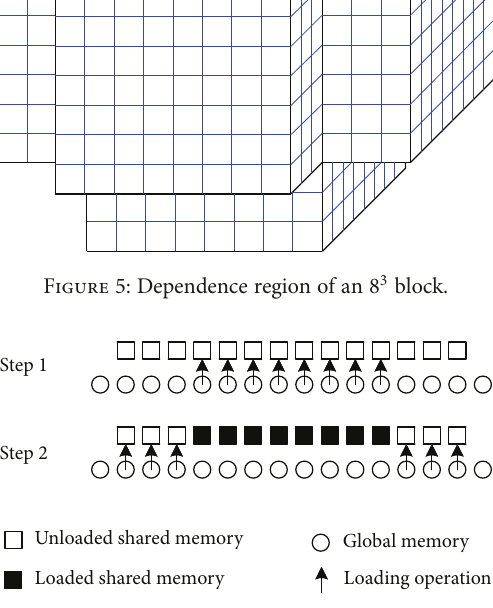
Figure 6: Loading fl ow on one